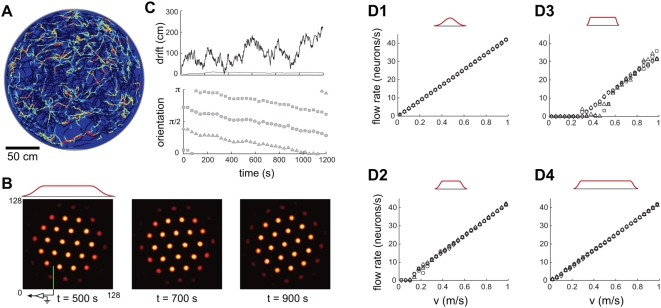
Boundary conditions and network size strongly affect fidelity of
network response.(A–C) Same simulation as in Figure 2D–F, but with a
sharper input profile (red curve above B). The SN pattern has no
periodicity (A), the integration error is large (thick line in (C),
upper plot; note the different scale compared to Figure 2E, whose
error is represented by the thin line), and the population response
rotates frequently ((C), lower plot). (D1–D3) Network
velocity response as a function of different input profiles: Input
profile decay is least abrupt in (D1), more abrupt in (D2), and most
abrupt in (D3) ( for (D1), (D2), and (D3), respectively; network
size is 128 neurons per side() for all). (D4) The input profile at the
boundaries is identical to D2 (), but the network is larger (256 neurons per side
or ). (D2) corresponds to the parameters in
(A–C), and (D1) corresponds to the parameters in Figure
2D–F.